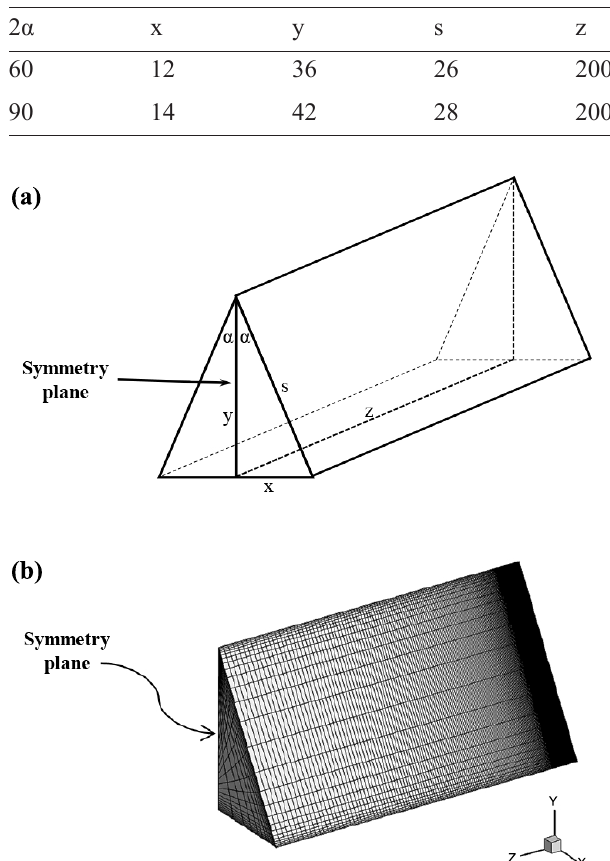
Table 1. The selected grid for numerical simulation (x, y, s, and z are presented in Figure 1a).